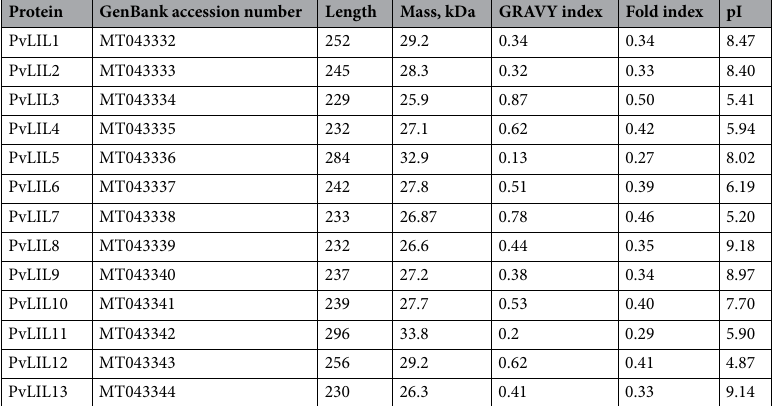
Table 1. The properties of amino acid sequences of PvLIL proteins. Data on molecular weight, theoretical isoelectric point (pI) and grand average of hydropathy (GRAVY) were obtained via analysis of sequences of proteins corresponding to PvLil genes by the ProtParam tool 18 . Fold index values were obtained via the FoldIndex service 52